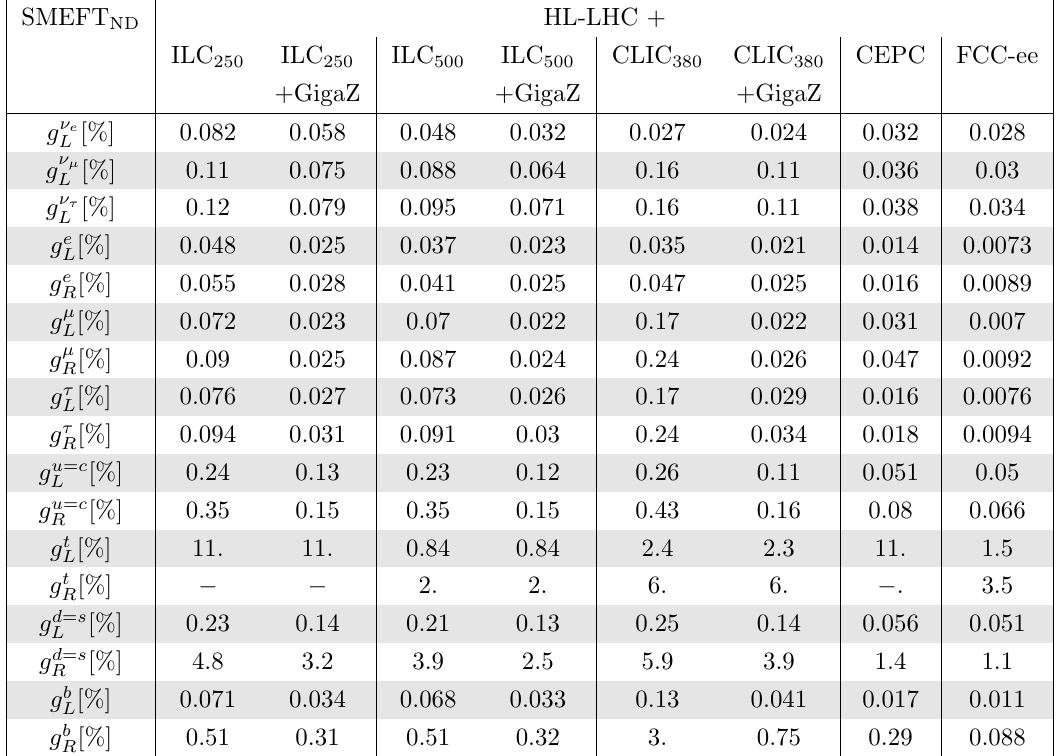
Table 34 . Comparison of the e(cid:11)ective Z -boson coupling sensitivities for the ILC and CLIC with p and w/o a dedicated running at s (cid:25) M Z . Also shown are the values for CEPC and FCC-ee In all cases, the combination with HL-LHC is shown but the sensitivity is dominated by the e + e (cid:0) collider. SMEFT ND